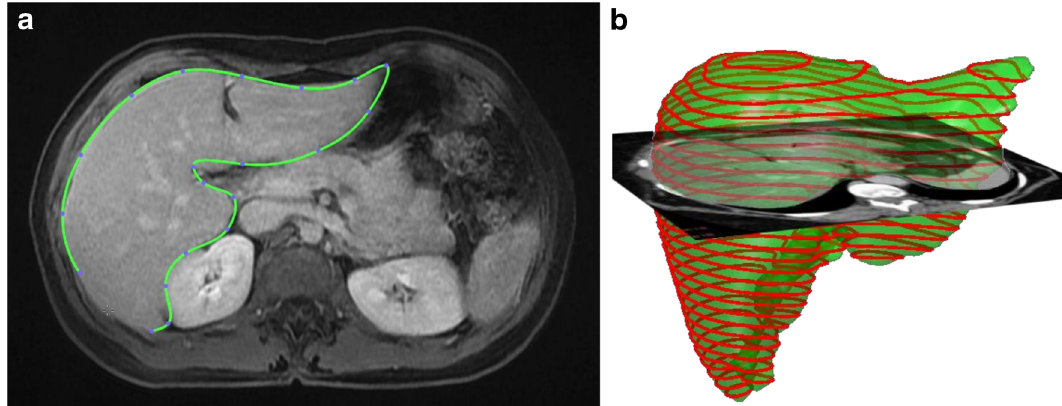
(Osirix Foundation, Geneva, Switzerland). b Volume of the liver is ob- tained based on pixel size and slice